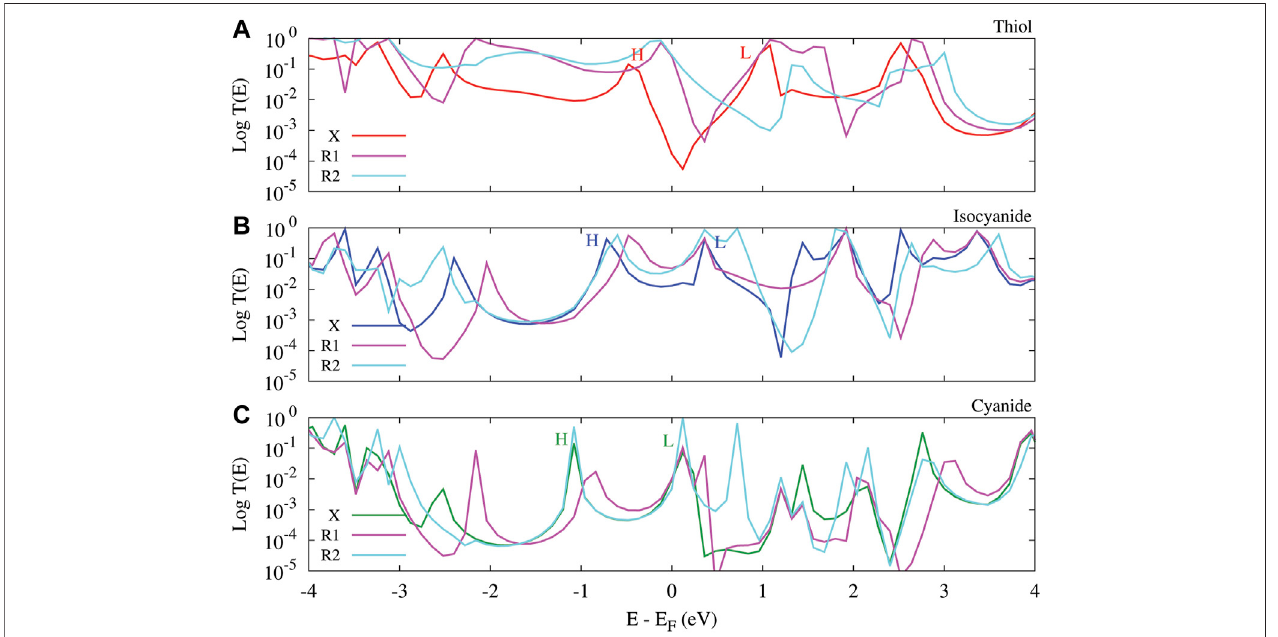
FIGURE 4 | The transmission spectrum versus energy for the anthracene molecule perturbed with the amine side group in R1 and R2 positions which was evaluated at T (cid:1) 300 K. The molecule was connected to the Au electrodes via thiol (A) , isocyanide (B) and cyanide (C) anchoring groups. The transmission of the unperturbed molecular junction (labeled X) is depicted as a reference. HOMO/LUMO peaks of the unperturbed system are labeled by letter H/L.